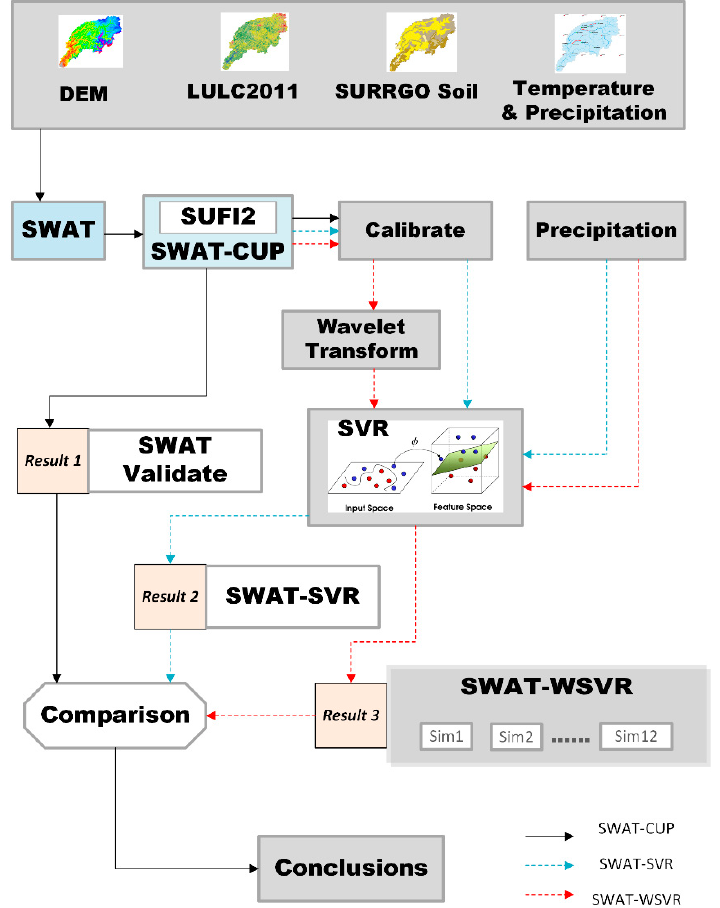
Figure 1. The developing flowchart of different models: SWAT-CUP, SWAT-SVR, and SWAT- WSVR.